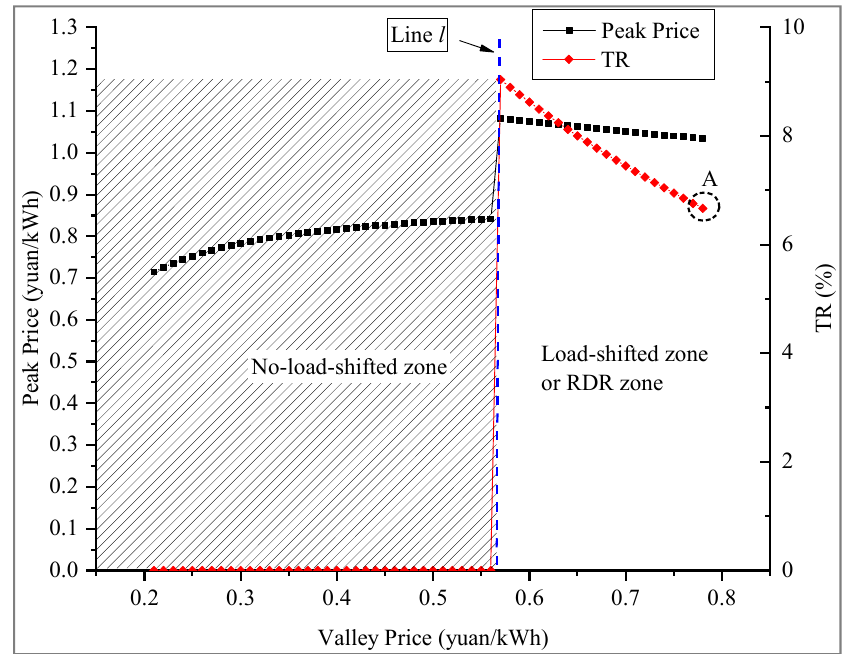
Figure 13. Results of valley price, peak price, and